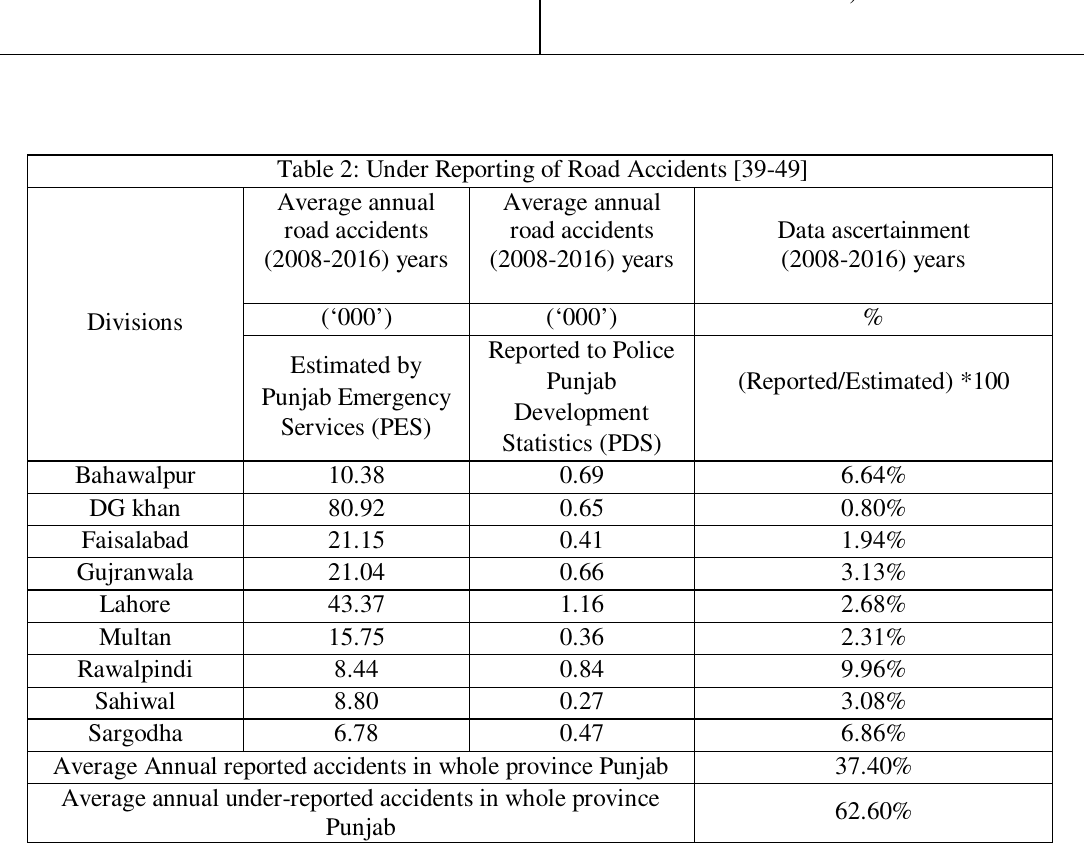
Fig. 11: Avg. Annual Road Accidents (Reported)